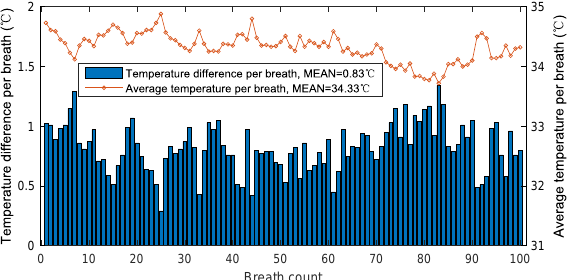
Figure 19. The temperature difference and average temperature per breath in high temperature